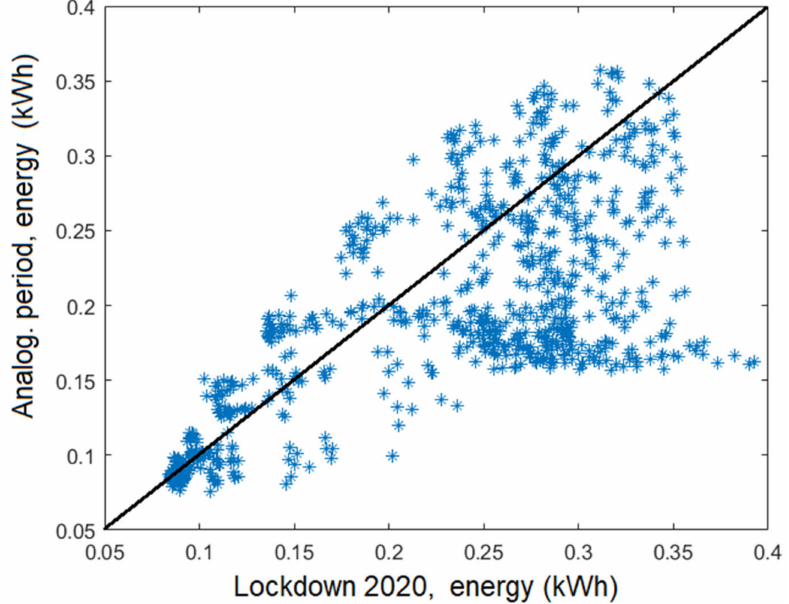
Figure 14. The scattering diagram of the 1-h active energy load averaged over dwellings (in relation to the lockdown and the same period of 2018); one point represents one of the 815 h of the analysed periods, and the straight line corresponds to the relation y = x.